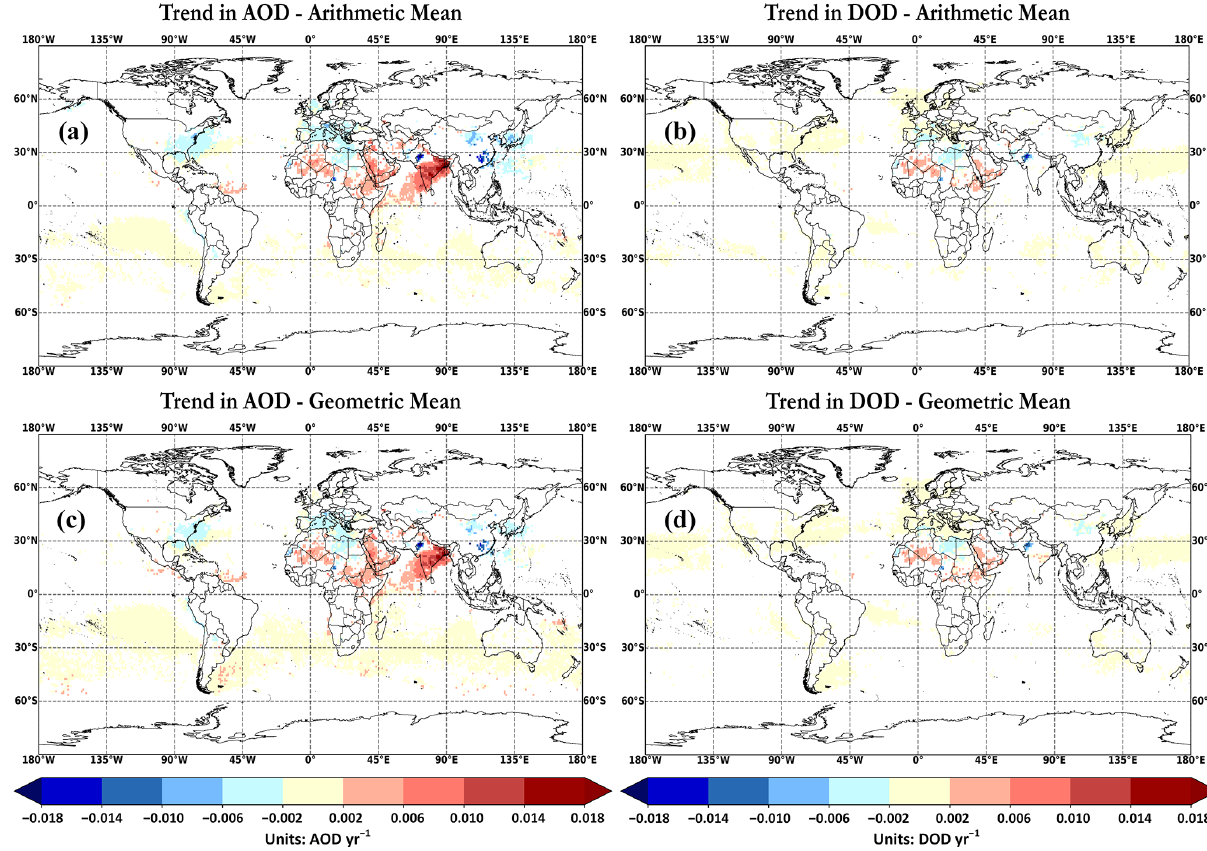
Figure 3. Same as Fig. 2 at 1 ◦ × 1 ◦ spatial resolution. Table 1. Comparison of the computed DOD trends between the current study and Voss and Evan (2020) over 15 regions of interest.